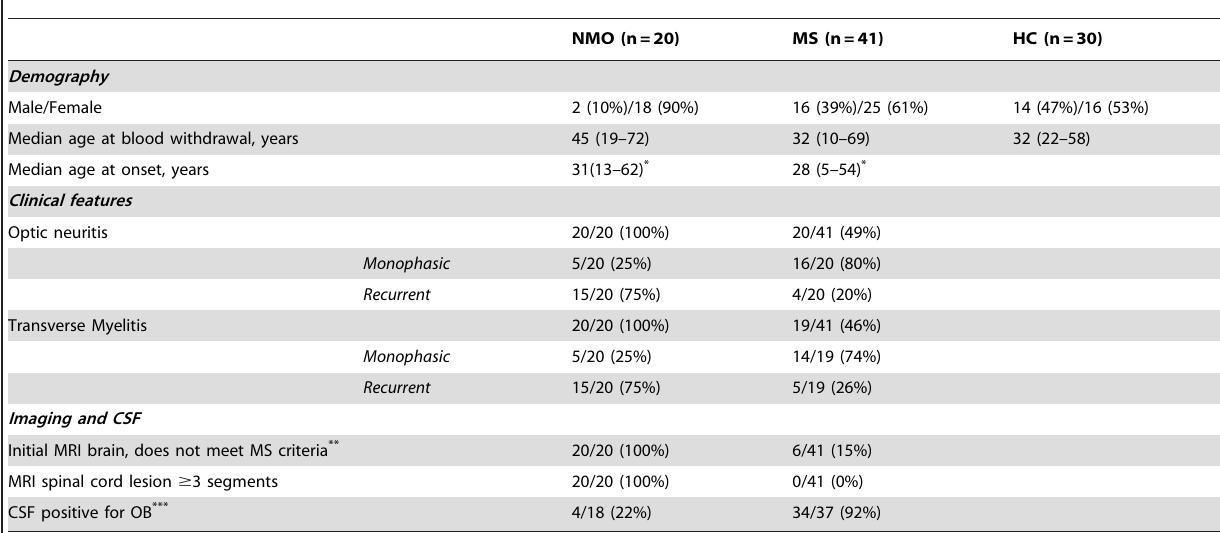
Table 1. Demographic and clinical characteristics of subjects.